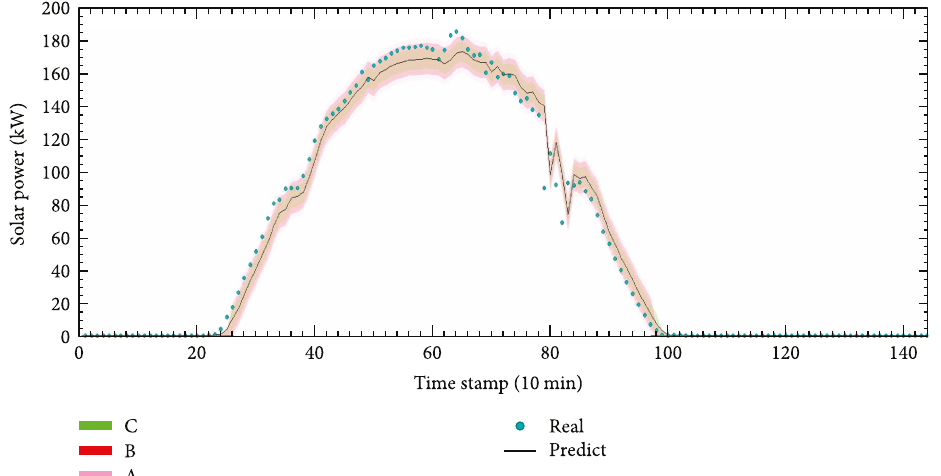
Figure 7: Fuzzy interval prediction for one day ahead (case 1) solar power with coverage